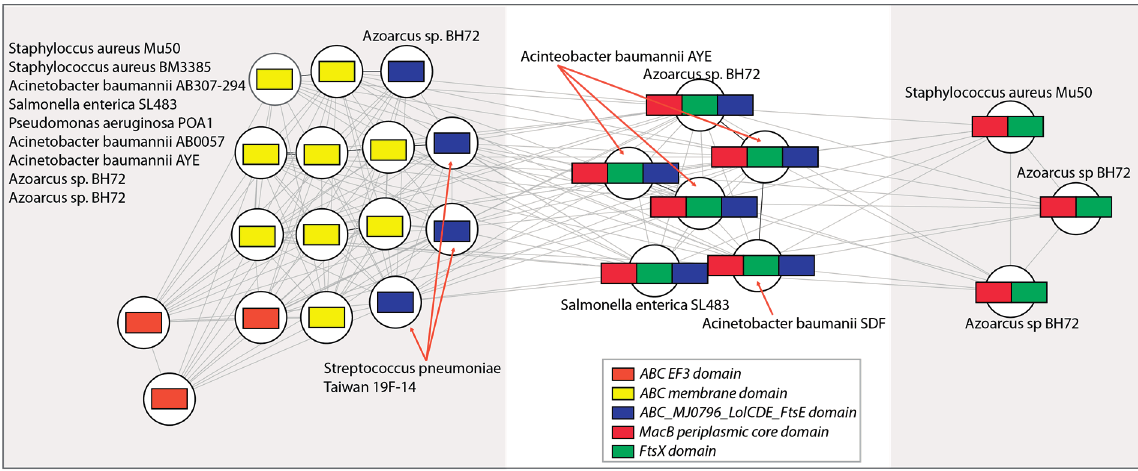
Figure 3. Sequence similarity network displaying significant similarities (network edges) detected by BLAST between the gene sequences (network